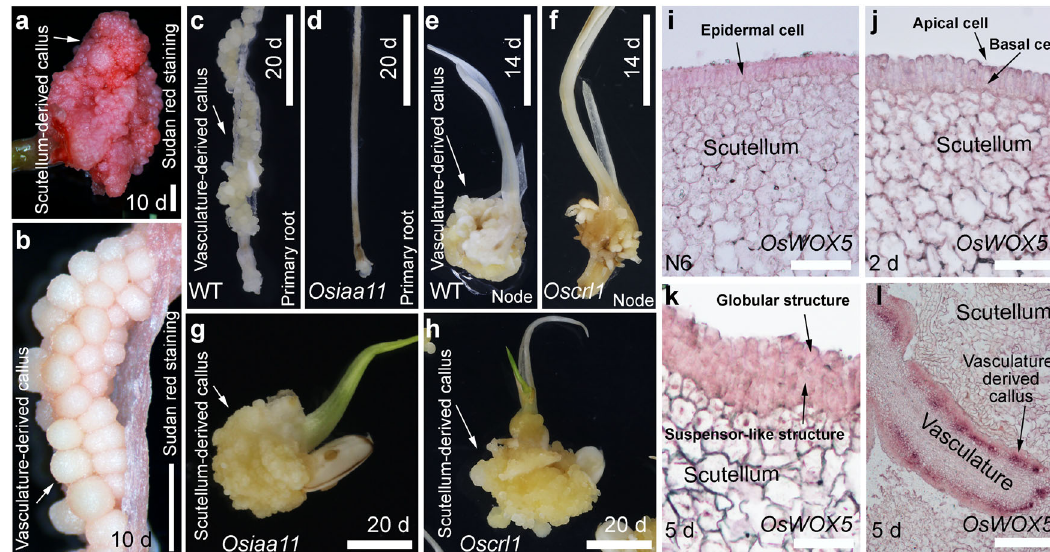
Fig. 3 Analysis of scutellum-derived and vasculature-derived calli in rice. a , b Sudan red staining of scutellum-derived callus from mature seeds ( a ) or vasculature-derived callus from root ( b ) on CIM at 10 d. c , d Primary roots of wild-type ( c ) and Osiaa11 ( d ) tissue-cultured on CIM for 20 d. e , f Nodes of wild-type ( e ) and Oscrl1 ( f ) tissue-cultured on CIM for 14 d. g , h Seeds of Osiaa11 ( g ) and Oscrl1 ( h ) tissue-cultured on CIM for 20 d. i – l In situ hybridization using anti- OsWOX5 probe in scutellum ( i – k ) and vasculature ( l ) of wild-type embryos in mature seeds at 2 d ( j ) or 5 d ( k , l ). Seeds cultured on N6 medium without hormone treatment for 2 d served as the control ( i ), because t 0 -seeds were dry and unsuitable for in situ hybridization. Some vasculatures in the embryo can initiate vasculature-derived callus with OsWOX5 expression ( l ). Scale bars, 1 mm ( a , b ), 5 mm ( c – h ), 50 μ m ( i – k ), 500 μ m ( l ).